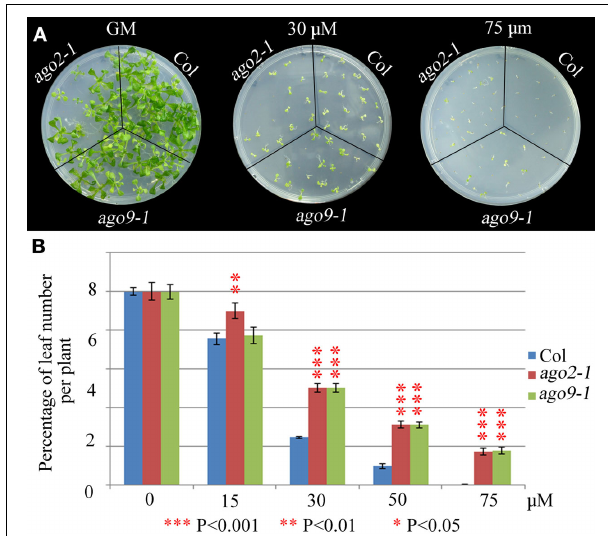
FIGURE 7 | WT plants are more sensitive to CDDP than ago2-1 and ago9-1 plants. (A) Phenotypes of 14-day-old seedlings ( ago2-1, ago9-1, and Col) sown on media containing different concentrations of CDDP. (B) Percentage of leaf number per plant after treatment with different concentrations. Leaf number at each dose was scored and put into relation to the leaf number of the untreated plantlets of the same line. Mean values and standard errors are depicted. Asterisks indicate P -values from t -Student tests: ∗∗∗ P < 0 . 001, ∗∗ P < 0 . 01, and ∗ P < 0 . 05. See Supplementary Table S2 for more